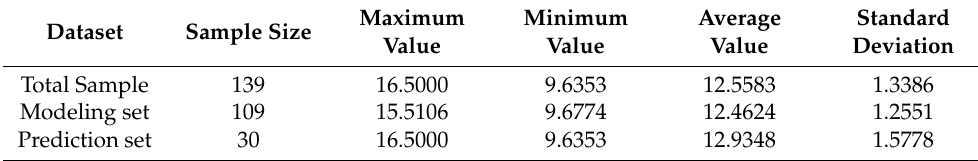
Table 1. Dry basis moisture content of sample and results of sample sets